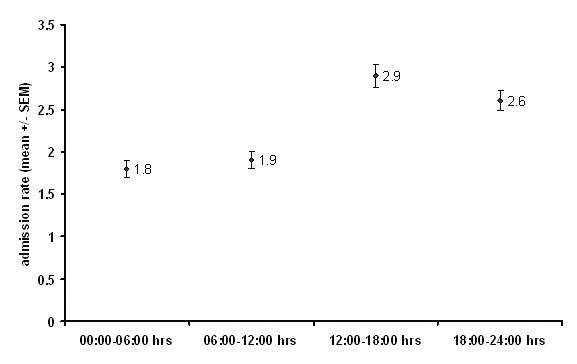
Timing of admission and peak hours. Results are expressed as mean ± standard error of mean.